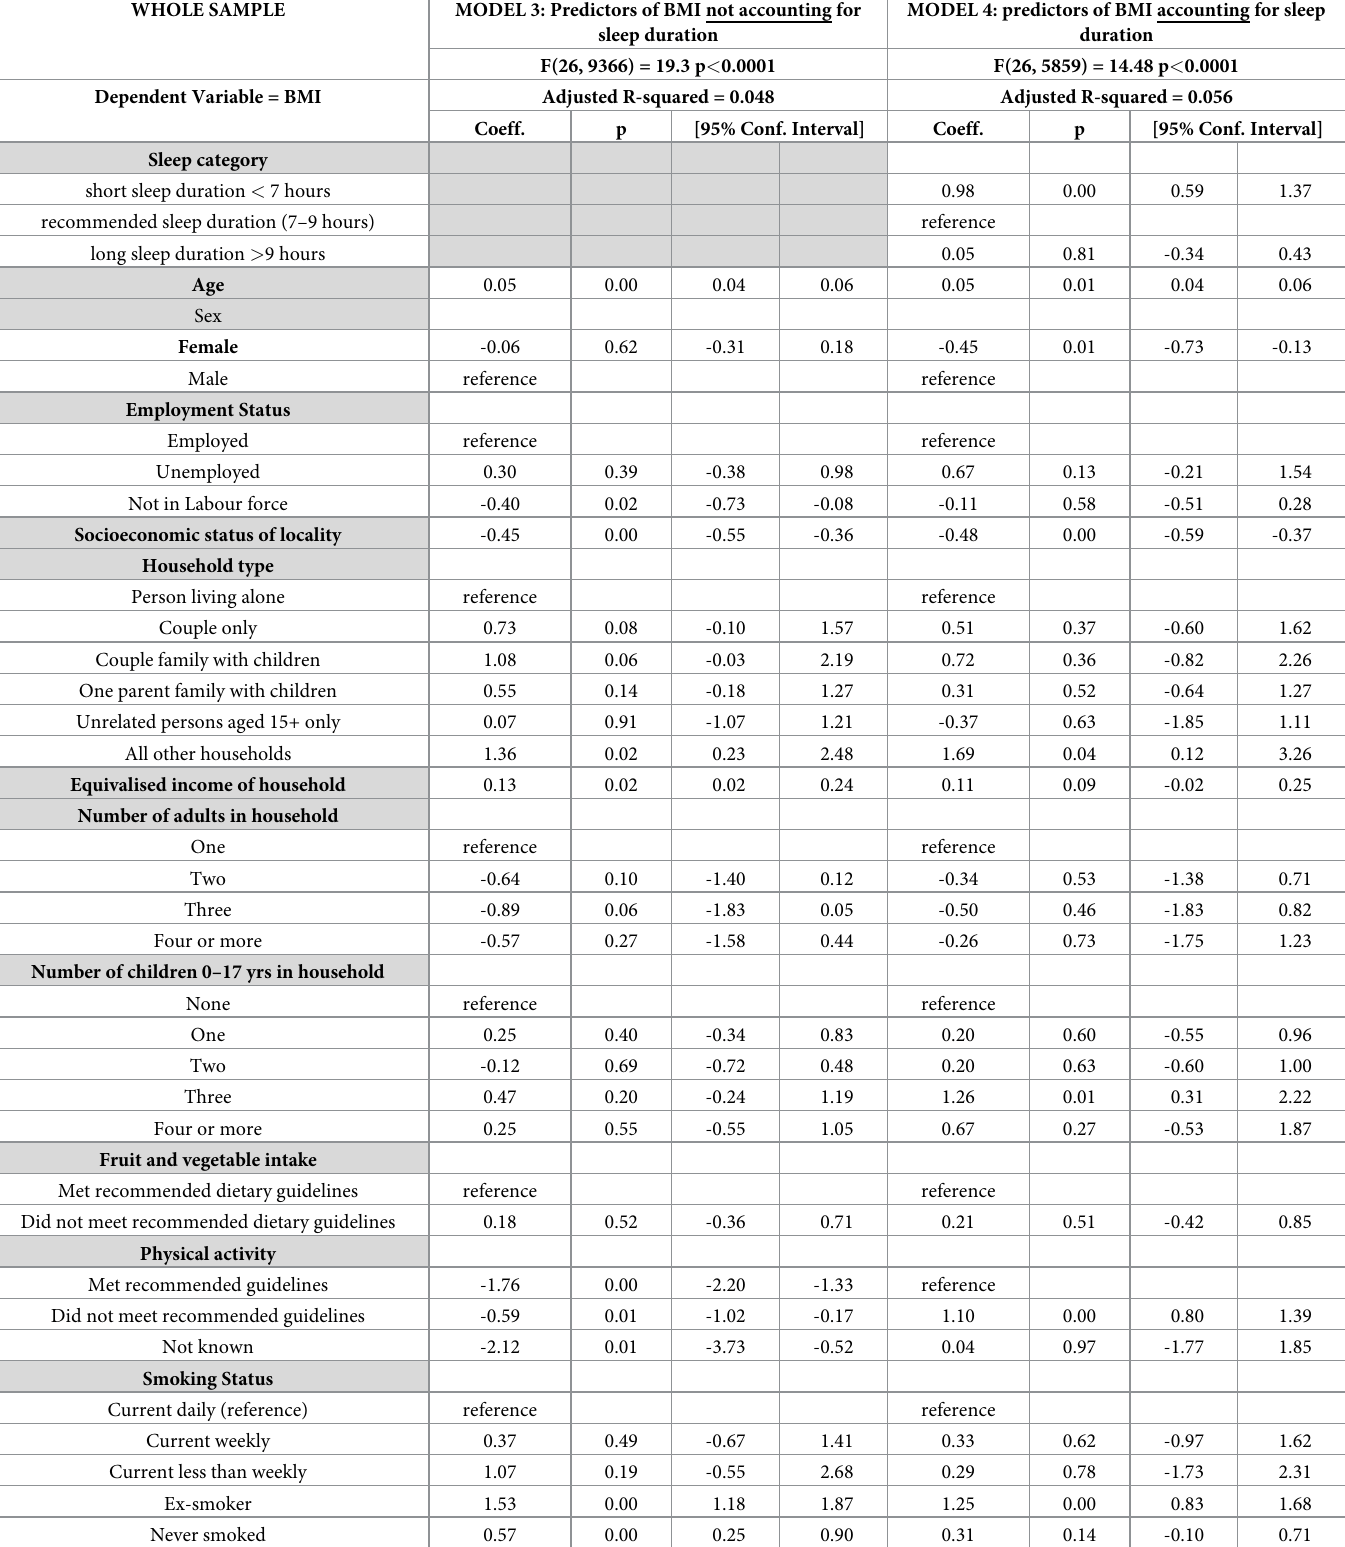
Table 3. Predictors of BMI. WHOLE SAMPLE MODEL 3: Predictors of BMI not accounting for